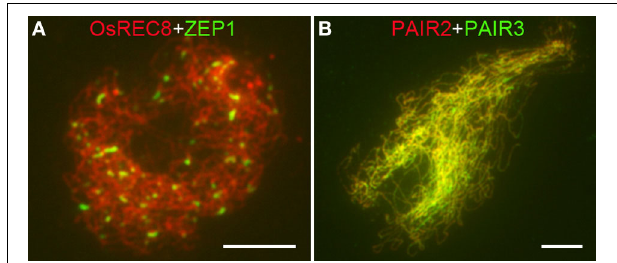
FIGURE 5 | Dual immunolocalization of several meiotic elements in Osrad51c PMCs. (A) OsREC8 (red) and ZEP1 (green) signals at early pachytene; (B) PAIR2 (red) and PAIR3 (green) signals at early pachytene. Bars, 5 μ m.